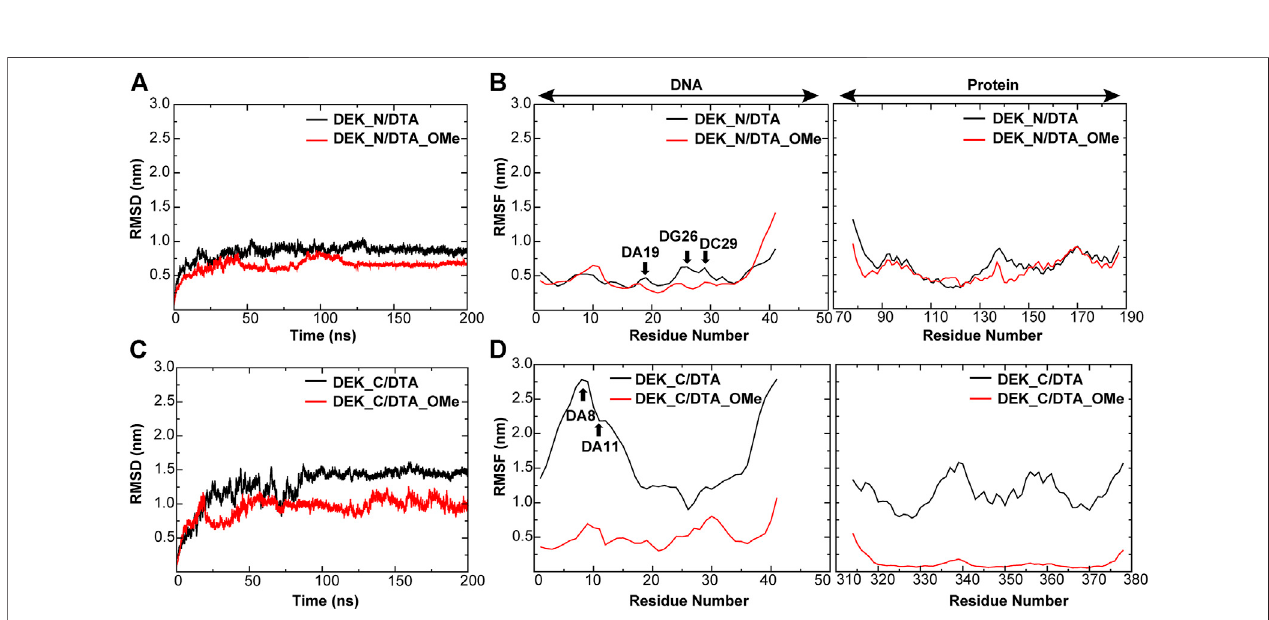
FIGURE 6 | RMSD and RMSF of different protein – DNA complexes. (A,B) DEK_N/DTA, DEK_N/DTA_OMe complexes (C,D) DEK_C/DTA, DEK_C/DTA_OMe complexes. The nucleotides with the large changes of RMSF before and after modi fi cation are labeled.